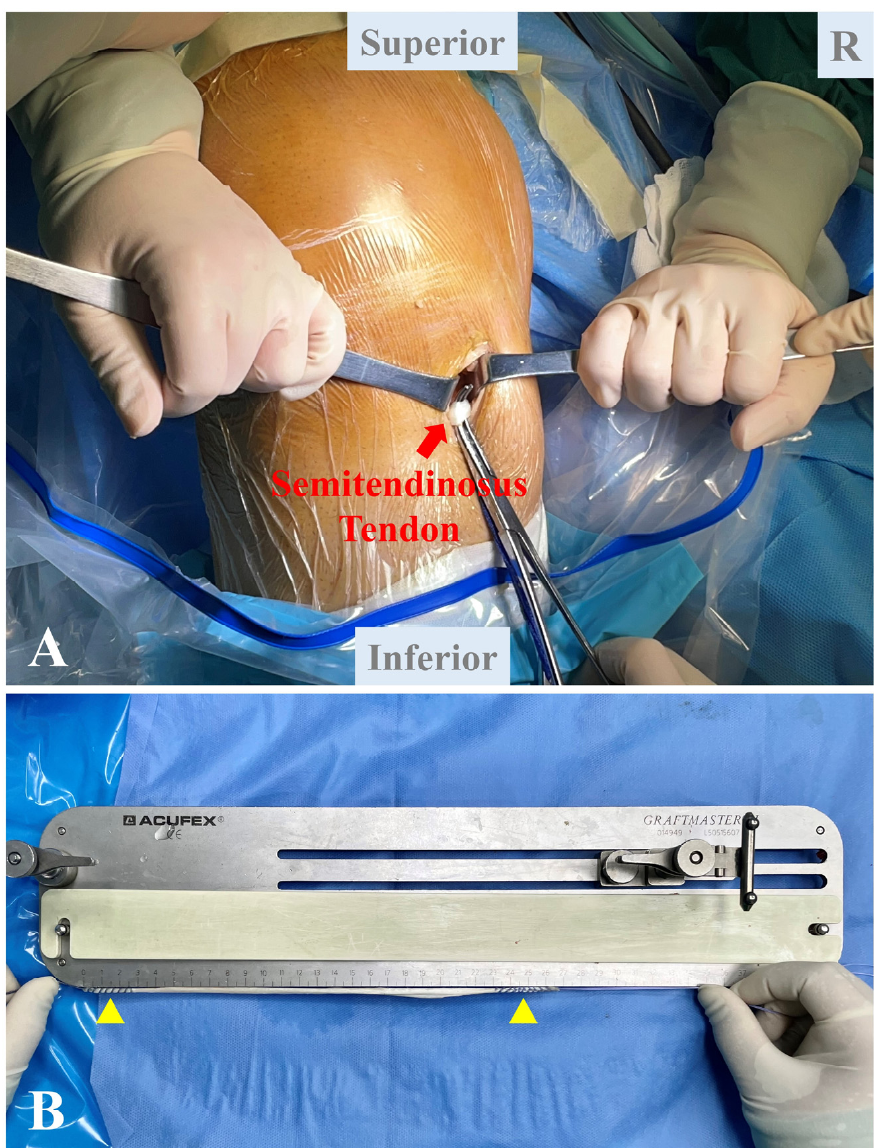
Figure 2. Autograft preparation. ( A ) The semitendinosus tendon is harvested through a 2 cm longitudinal incision 2 cm medial to the tibial tubercle. ( B ) The tendon is cleaned, and its two free ends are whip-stitched (yellow triangles).